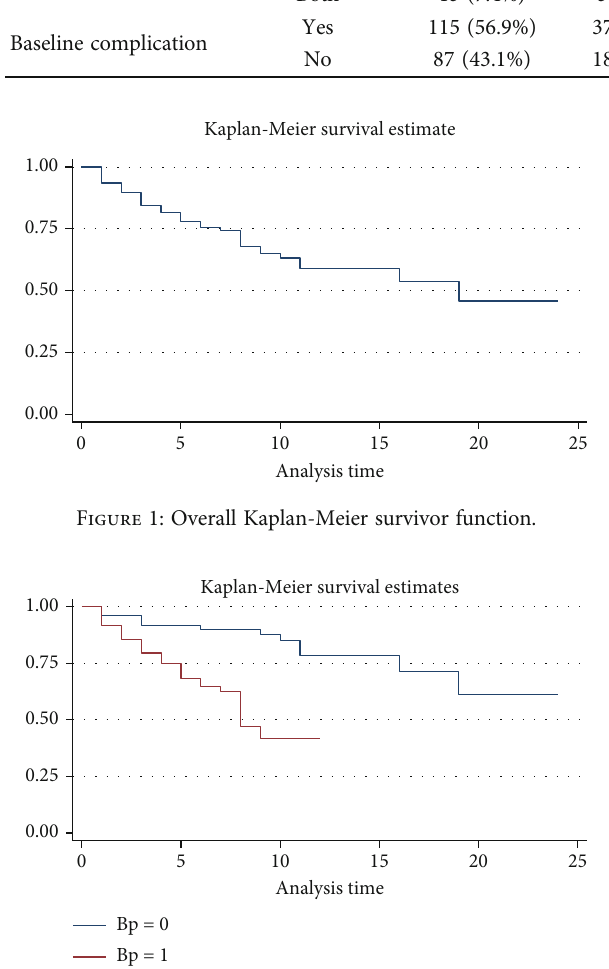
Figure 2: K-M plot survival of time-to-death by hypertension of stroke patients.